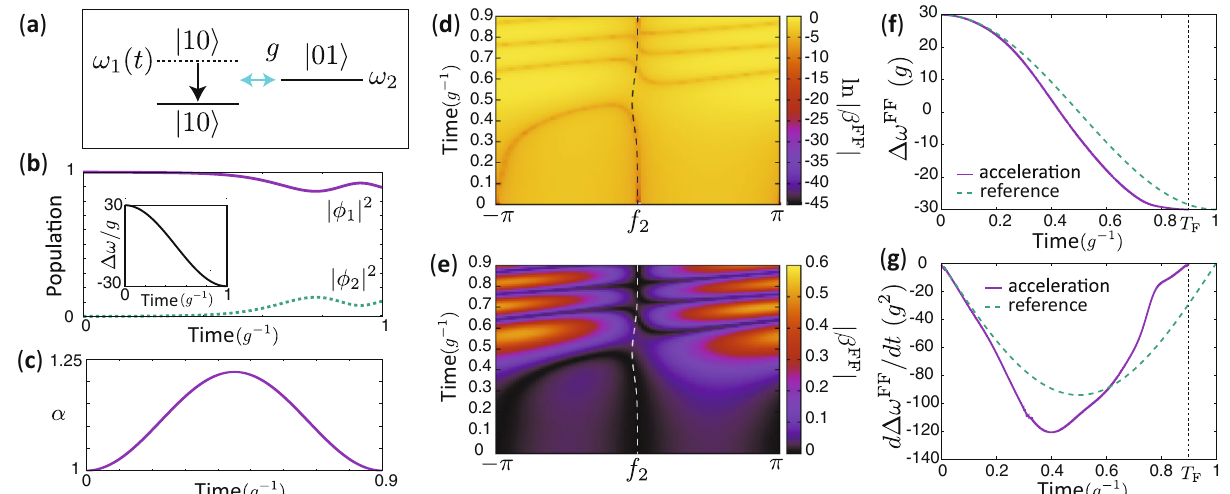
Figure 1. Schematic of the system, and speed-controlled and virtual trajectories for acceleration. ( a ) Schematic of the system. ω 1 is decreased gradually, while ω 2 and g are fixed. There is population transfer from | 10 � to | 01 � . ( b ) Time dependence of population of | m � in the reference dynamics. The inset shows the time dependence of �ω = ω 1 − ω 2 . ( c ) Time dependence of the magnification factor α for the case of acceleration. The used parameters are �ω 0 = 30 g , T = g − 1 and T F = 0.9 g − 1 . ( d,e ) ln | β FF | and | β FF | as functions of f 2 and t for T F = 0.9 g − 1 . The dashed curves show a virtual trajectory. ( f ) Time dependence of �ω FF = ω FF 1 − ω FF 2 for the virtual trajectory and �ω for the reference dynamics. ( g ) Time dependence of d �ω FF / dt and d �ω/ dt